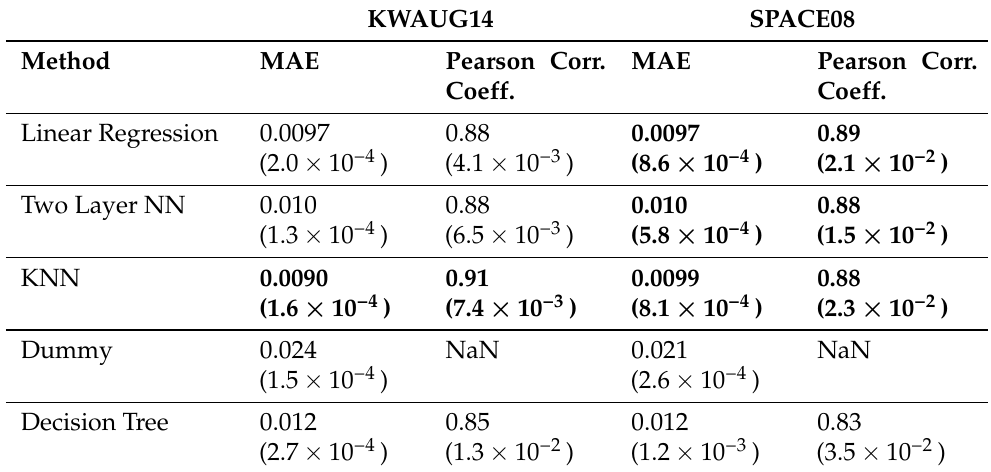
Table 4. Conventional regression results using CNN-derived features.